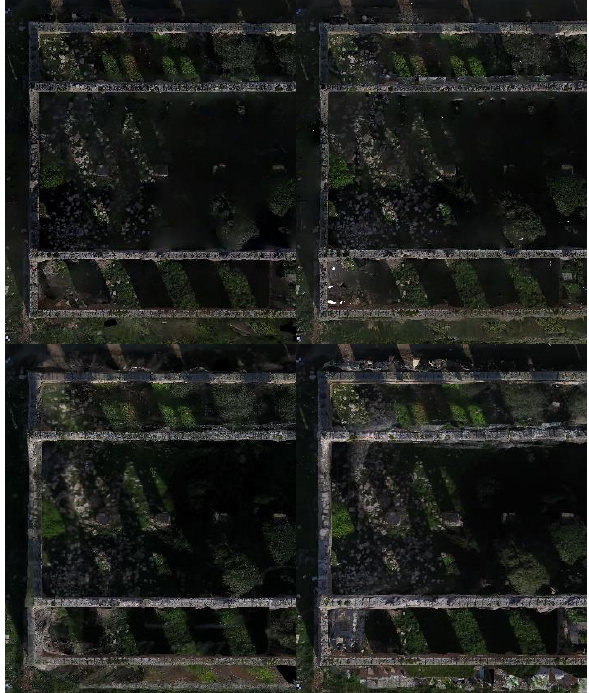
Figure 20. Comparison among different plans from video: from us (a), from SBM2017 participants (b, c, d).